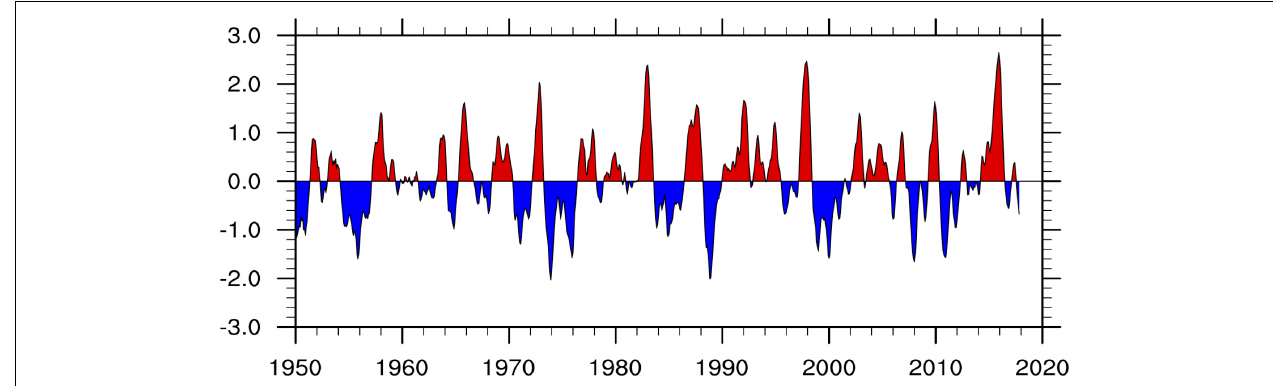
FIGURE 1 | The running 3-month mean SST anomaly for the Niño 3.4 region from 1950 to 2017 with the 1950–2000 as the base period. Unit of SST anomaly is degree Celsius.